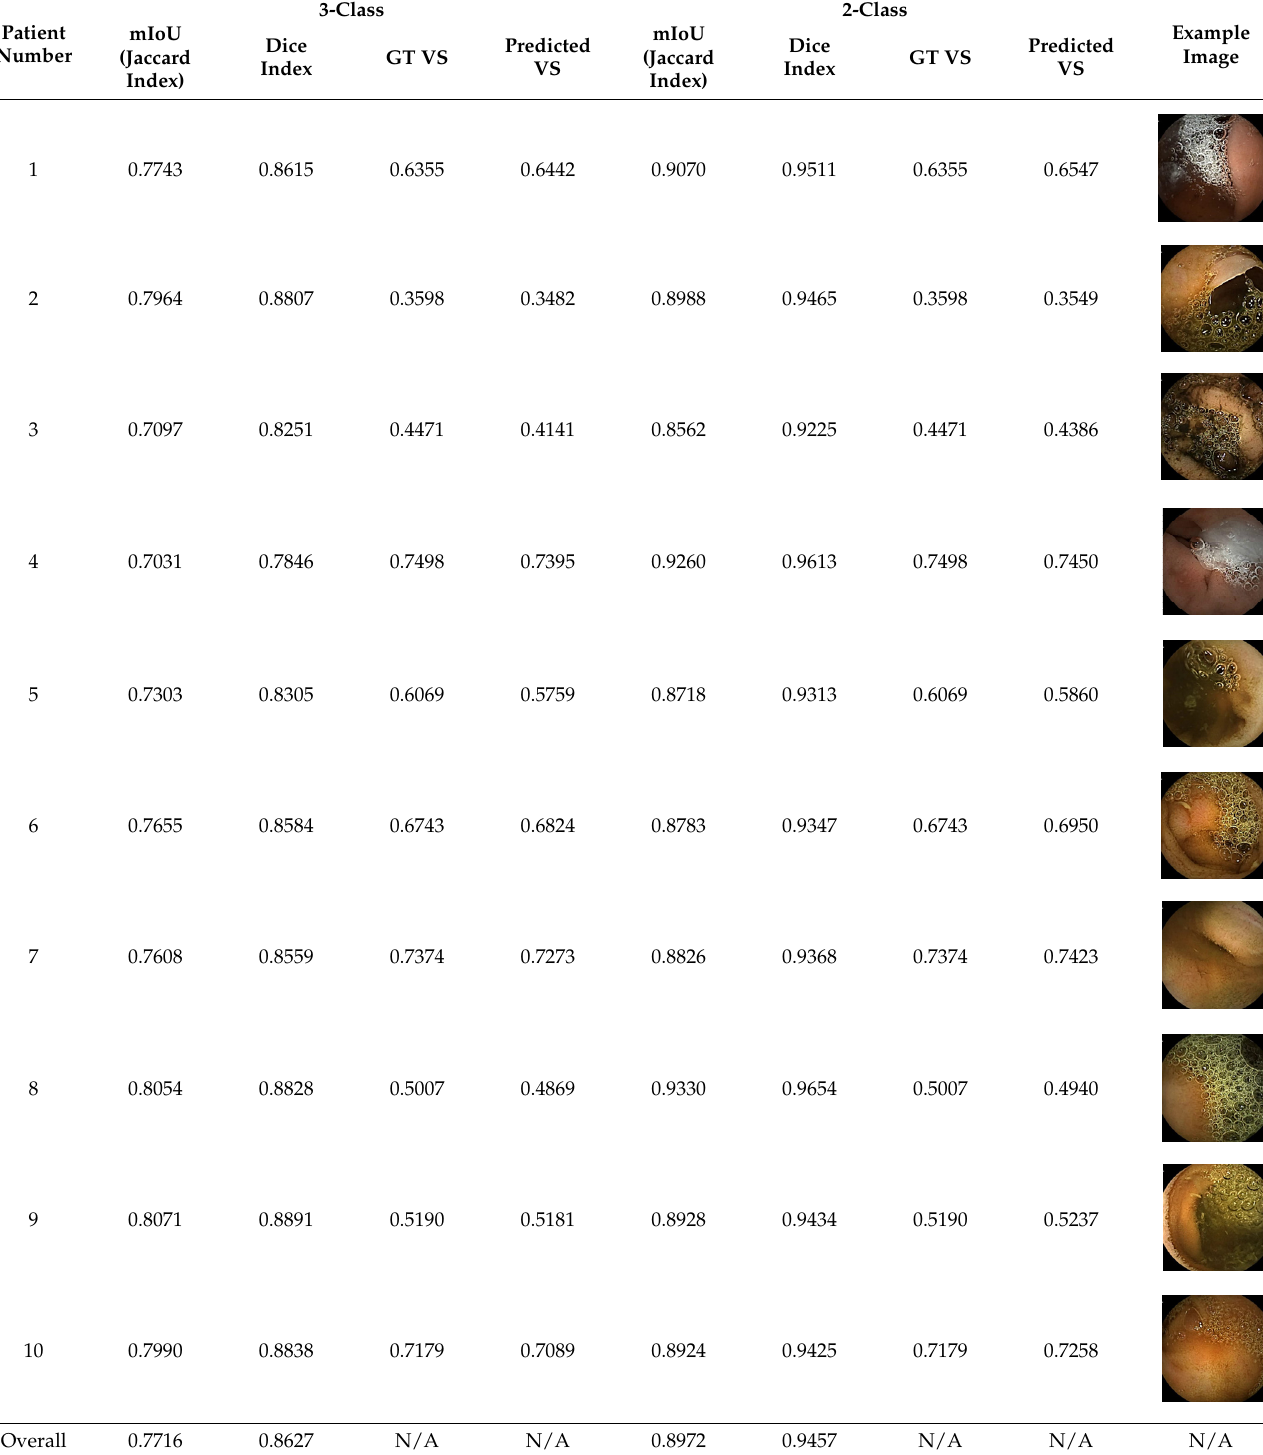
Table 4. Our semantic segmentation performance and its corresponding visualization scale (VS) on each test patient based on the results from DeepLab v3. Overall VS is not available since it is solely valid for an individual patient. (mIoU: mean intersection over union); GT VS (ground truth of visualization scale). (Jaccard In-